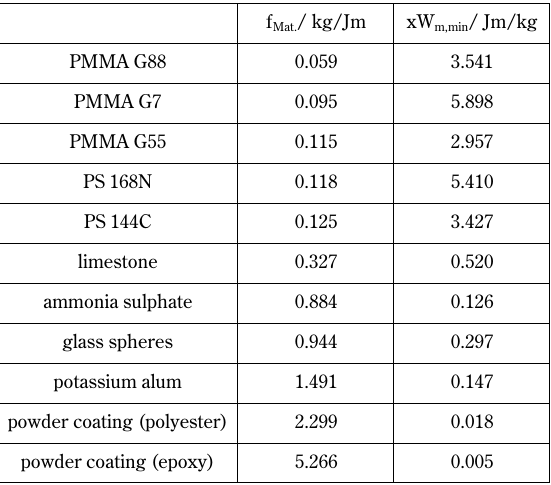
Table 1 Material parameters f Mat. and xW m,min determined from single particle tests